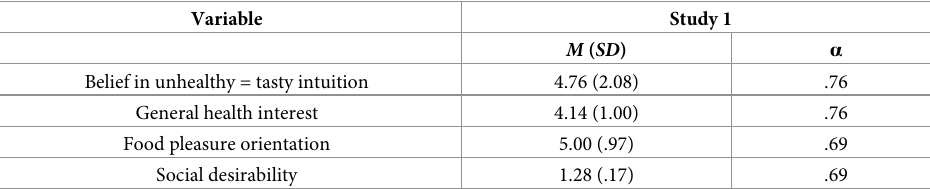
Table 1. Descriptive statistics and Cronbach’s alpha coefficients for the